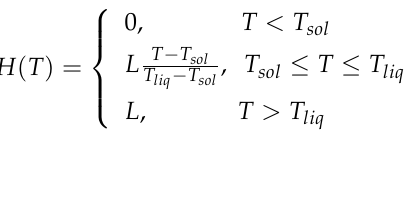
( c ) Figure 2. Phase change processes: ( a ) isothermal (for pure material); ( b ) linear; ( c ) general case.